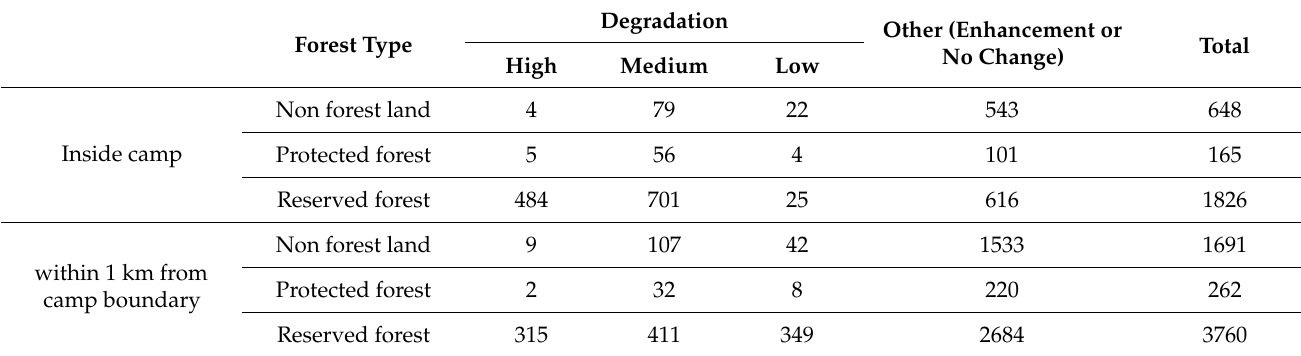
Table 3. Land degradation in Cox’s Bazar south forest division (areas are in ha) .